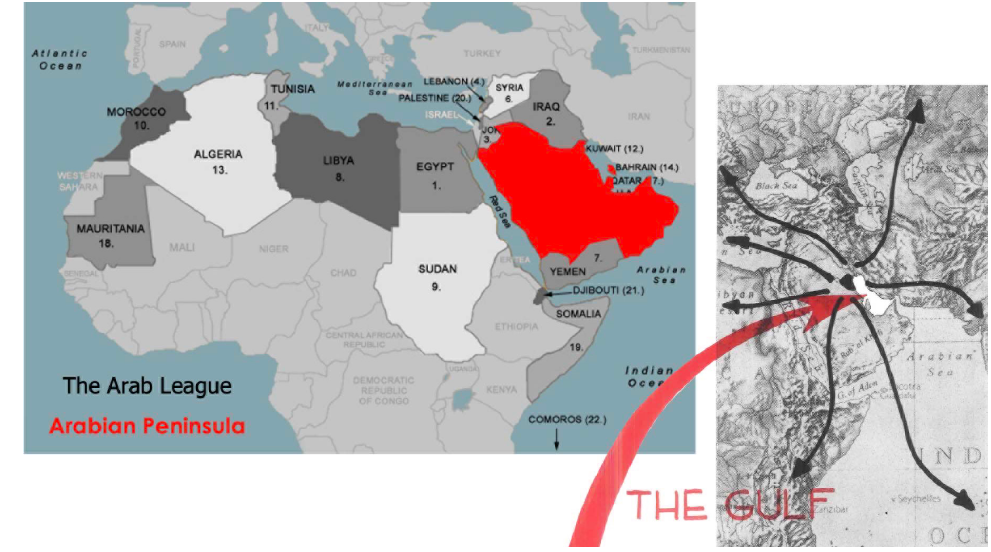
Fig. 3 Plan of the Arab league states highlighting in red the Gulf states by the author and the Gulf Map by Shiber. Source: Saba Shiber, The Kuwait Urbanization, (Kuwait: Kuwait Government Press,